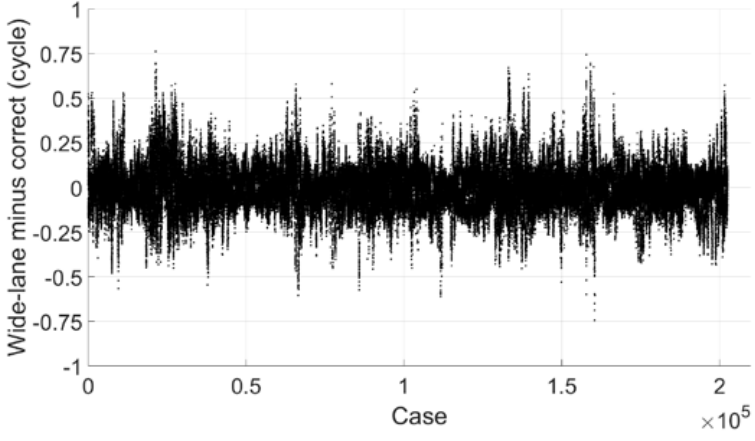
Figure 21. Wide-lane ambiguity minus correct integer ambiguity (GPS). (3) Narrow-lane ambiguity resolution The resolution of narrow-lane ambiguity will first be based on the following equation: